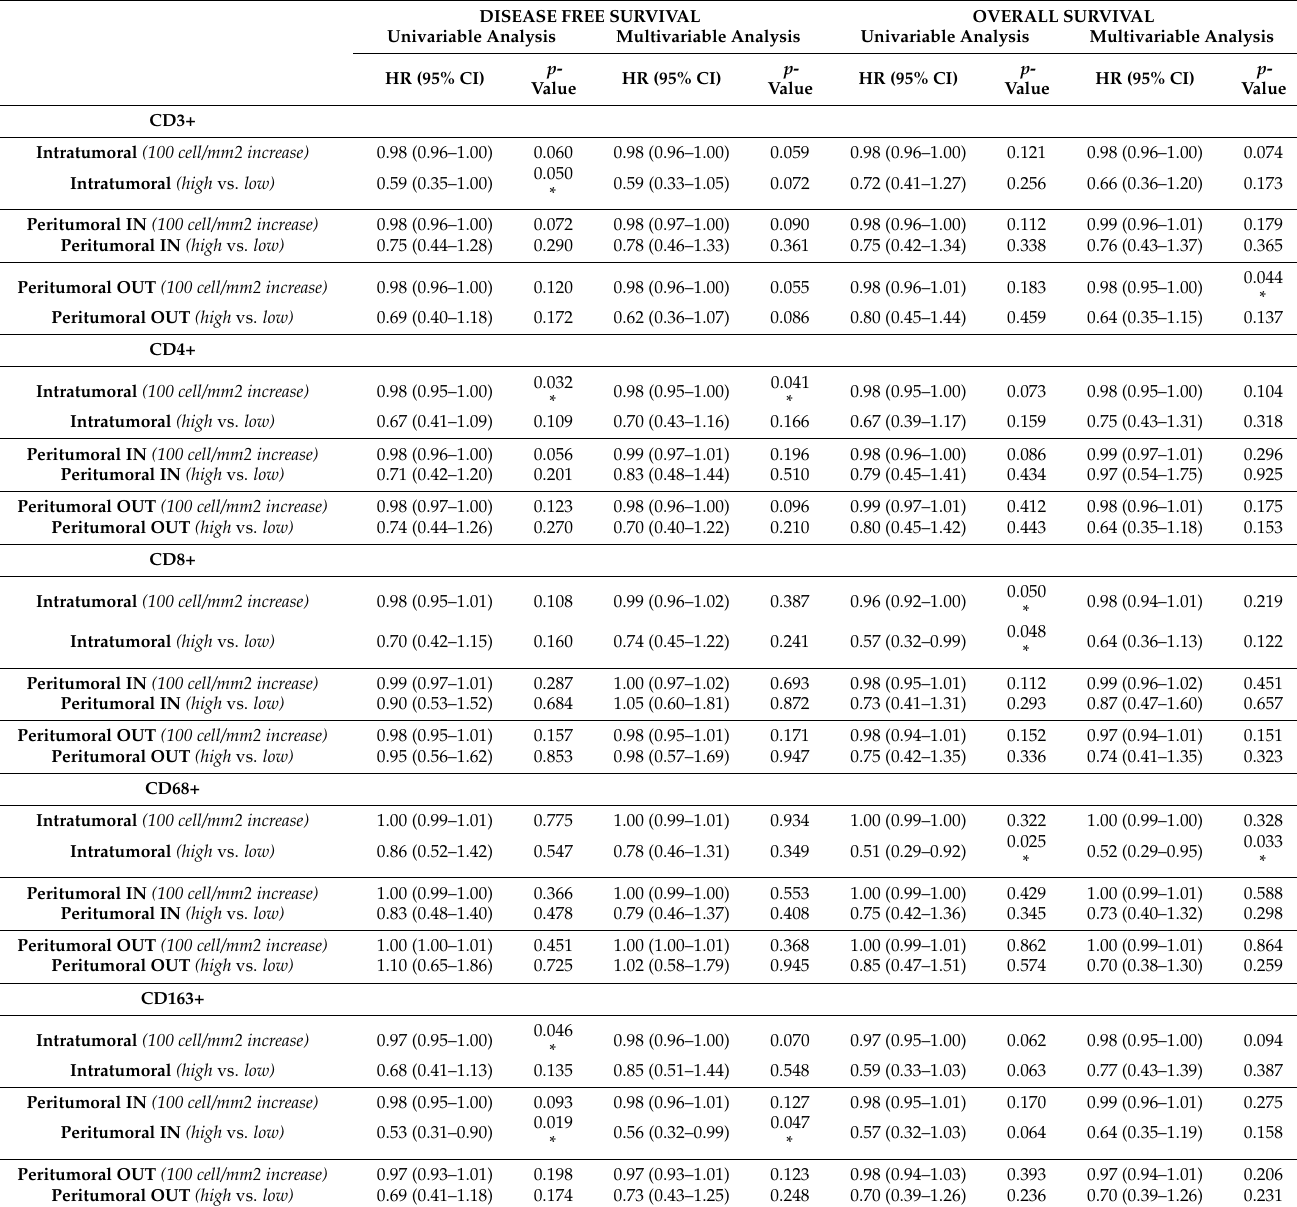
Table 3. Effect of biomarkers density on disease free survival and overall survival in the training cohort. Univariable and multivariable Cox proportional hazard